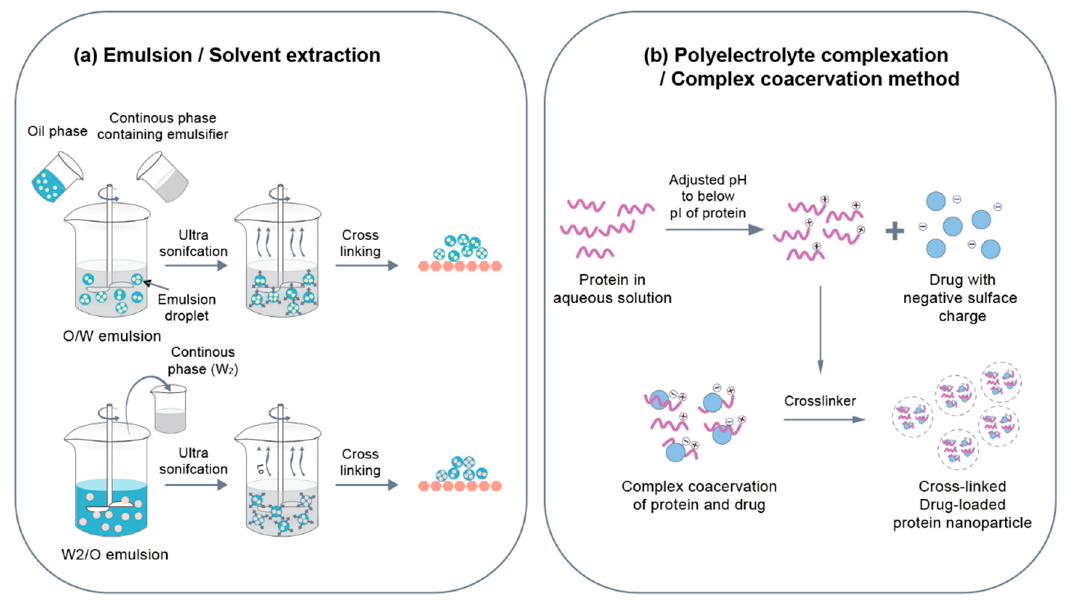
Figure 3. ( a ) The emulsion process is a method of forming nanoparticles by removing